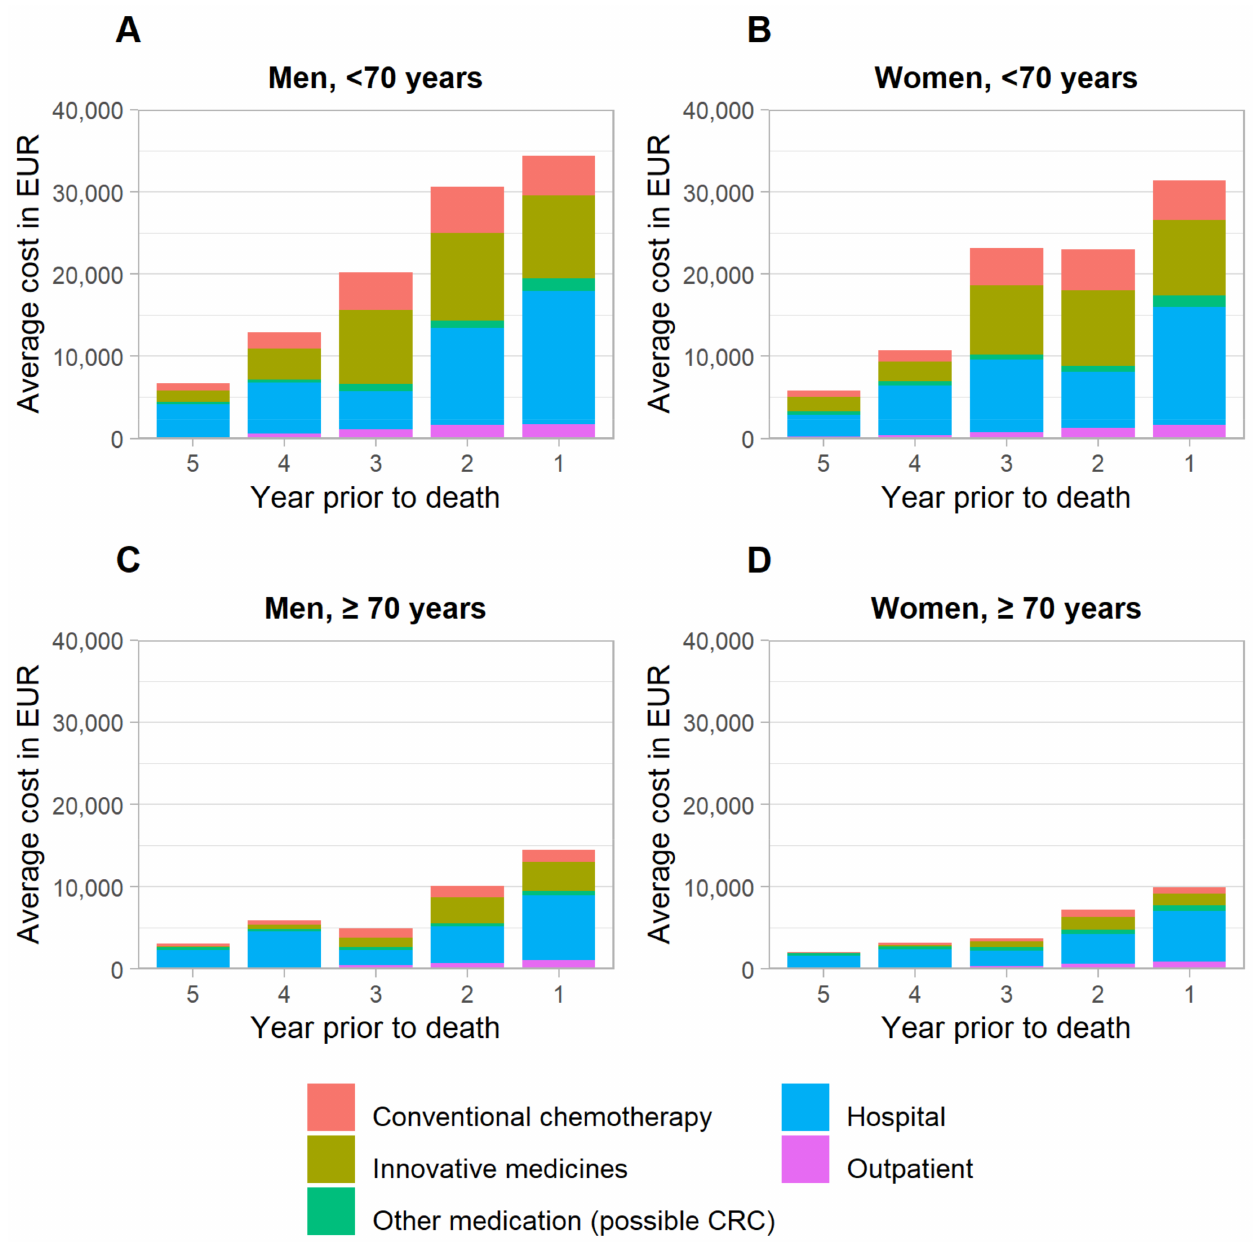
Figure 3. Breakdown of average treatment costs prior to death, stratified by sex and age. CRC, colorectal cancer. ( A ): Men, <70 years, ( B ): Women, <70 years, ( C ): Men, ≥ 70 years, ( D ): Women, ≥ 70